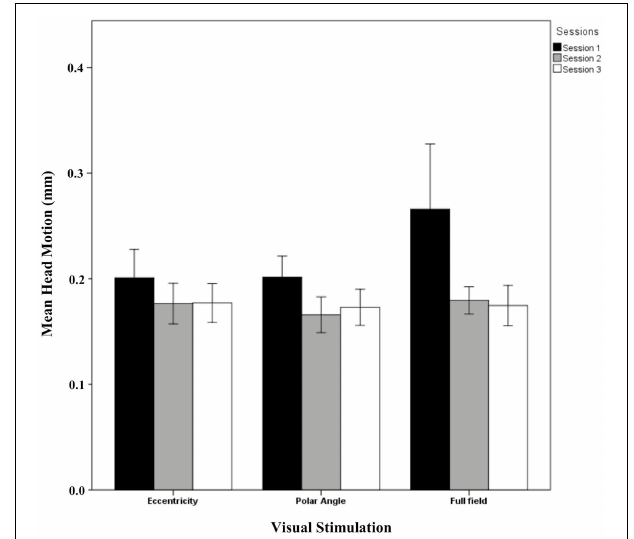
FIGURE 5 | Quantitative comparison of correlation of phase maps (re-transformed mean ± SEM of Z-transformed value) of between sessions 1 and 2, and between sessions 2 and 3 within defined visual for eccentricity and polar angle. No significant effects were observed as detailed in Results.